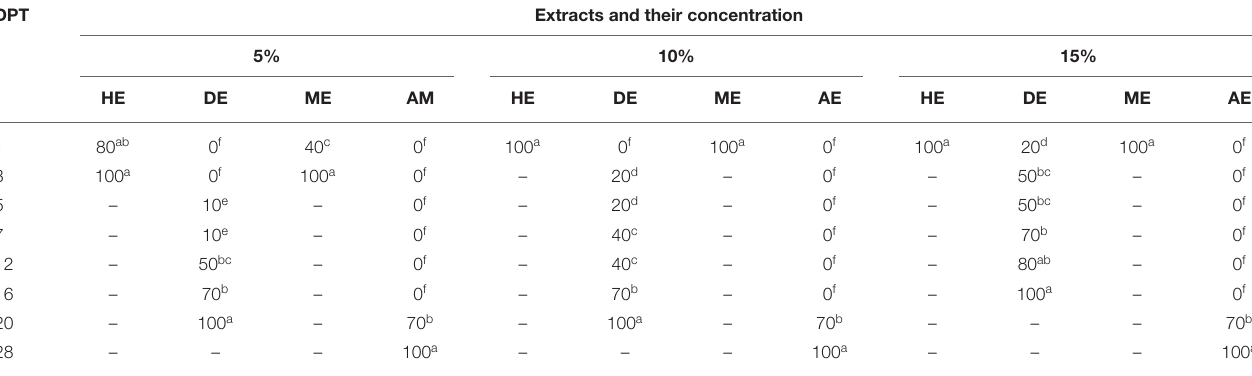
TABLE 7 | In vitro mortality rates of Hyalomma spp . nymphs treated with 5, 10, and 15% of hexane, methanol, dichloromethane, and aqueous extract emulsions of neem seeds.